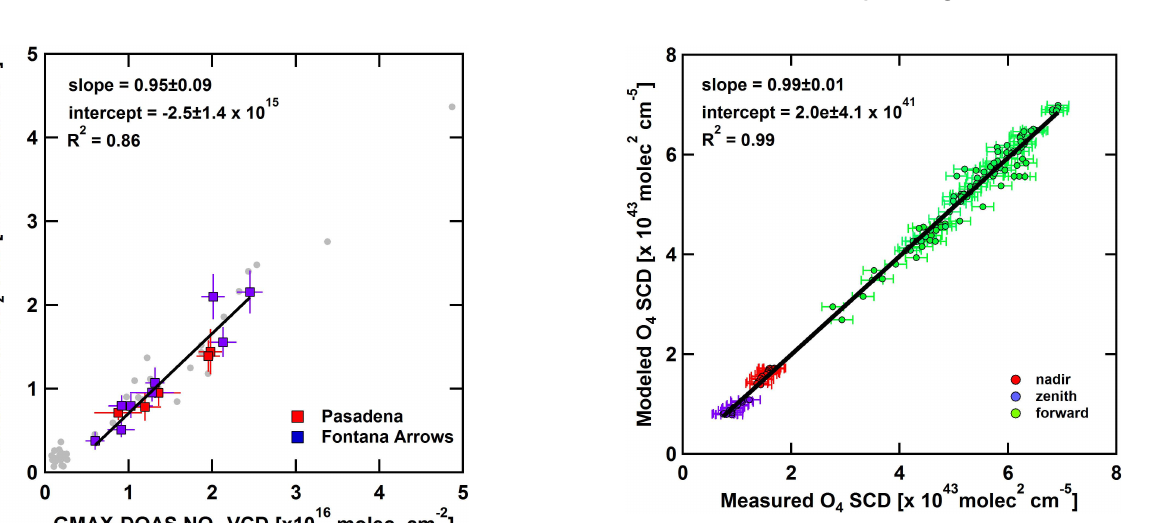
Fig. 8. Correlation plot of NO 2 VCDs between CU AMAX-DOAS and two MAX-DOAS instruments deployed in California during the CalNex and CARES field campaigns. Grey dots represent all data from both CalNex and CARES campaigns (see text for filter- ing conditions). Data from CalNex further constrained for relative azimuth between plane heading and MAX-DOAS viewing geome- try < ± 15 ◦ and NO 2 VCD variability < 8x × 10 15 moleculescm − 2 are shown in red and blue. Black line is the linear fit through the col- ored points.